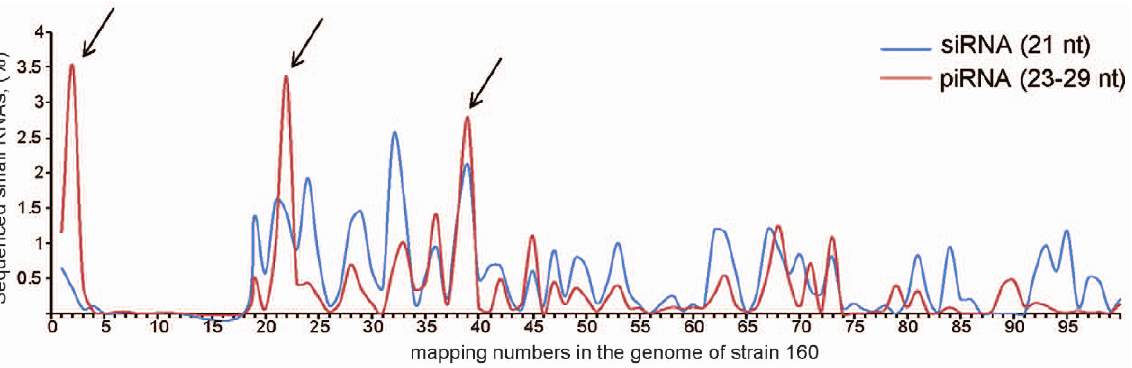
Figure 5. Frequency distribution of genomic mappings of Penelope –homologous si- and piRNAs. Arrows indicate a proportion of Penelope -derived piRNA sequences mapping 2, 22 and 39 times in D. virilis genome.